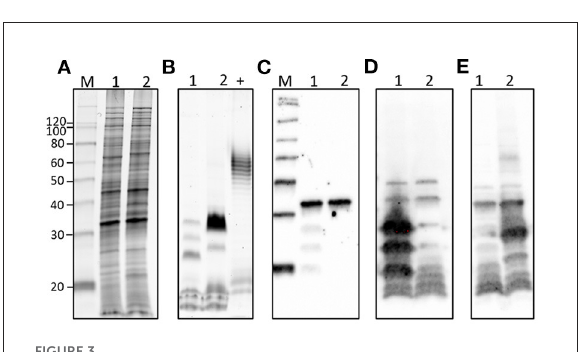
FIGURE3 Representative images of (1) L . borgeptersenii serovar Hardjo strain DCP-009 and (2) L . santarosai serogroup Pyrogenes strain DCP-017 showing (A) total protein profiles, (B) total lipopolysaccharide profiles, (C) immunoblotting with anti-LipL32, (D) immunoblotting with anti-serovar Hardjo and (E) immunoblotting with anti-serovar Alexi. Five microgram of each strain was loaded per lane. + ve; postive control for LPS staining comprising 5 µ g of E . coli serotype 055:B5. Molecular mass markers are